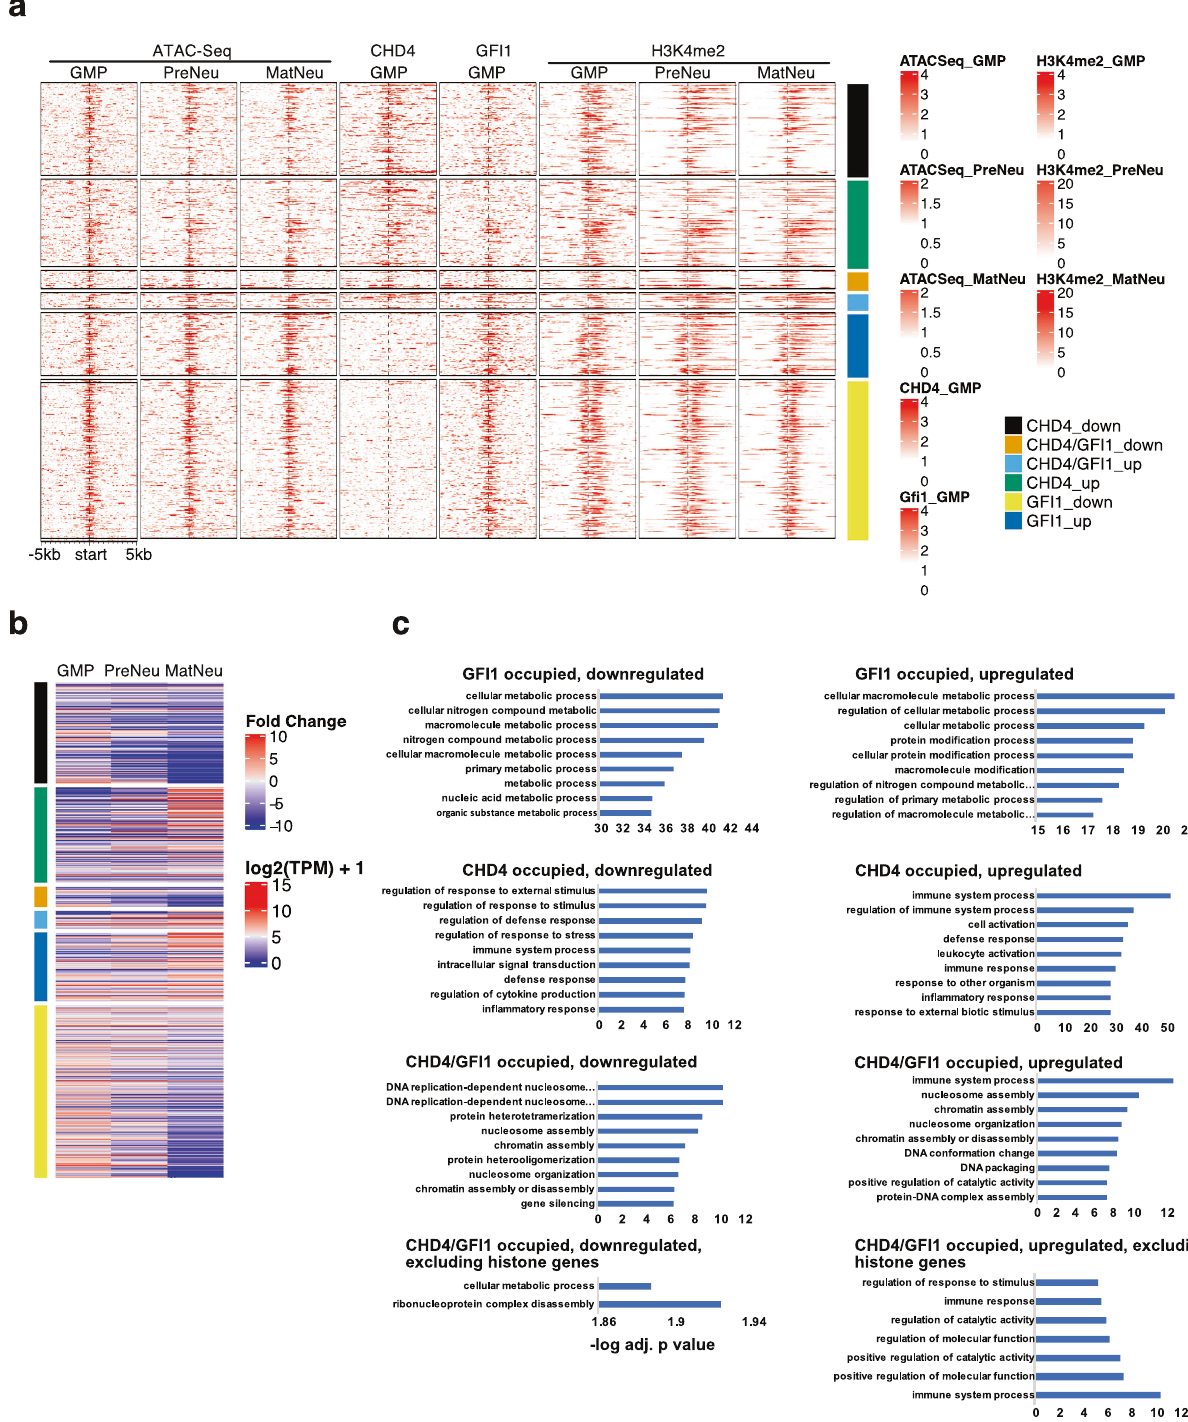
differentiation. Aggregation plots from ATAC-seq analyses suggest more accessibility at promoter sites at a narrow region around the TSS compared to the enhancer sites. However, the pattern of the ATAC-seq plot is different at enhancers where it is broader com- pared to promoters, where it is narrower. This does not allow to conclude that promoters are more accessible than enhancers but